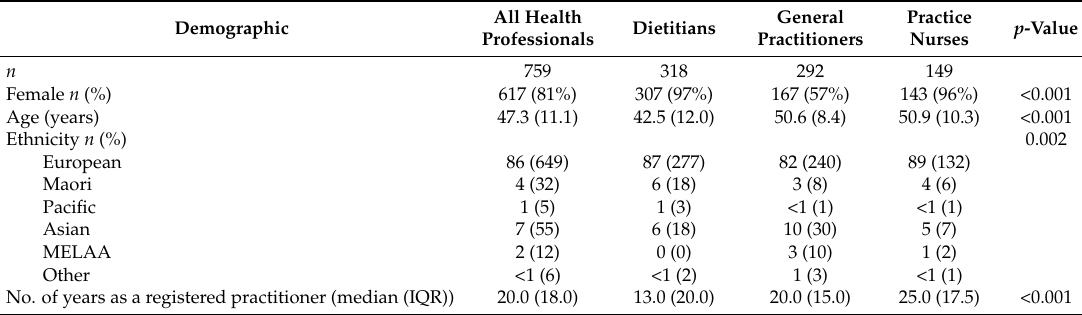
Table 2. Characteristics of study